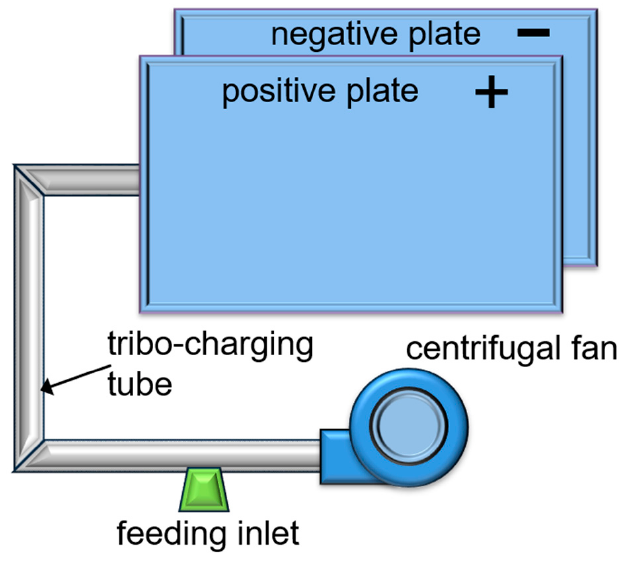
Figure 10. Schematic diagram of triboelectrostatic separation system. Table 4. Triboelectrostatic separation results of Zhundong and Shenfu coal.